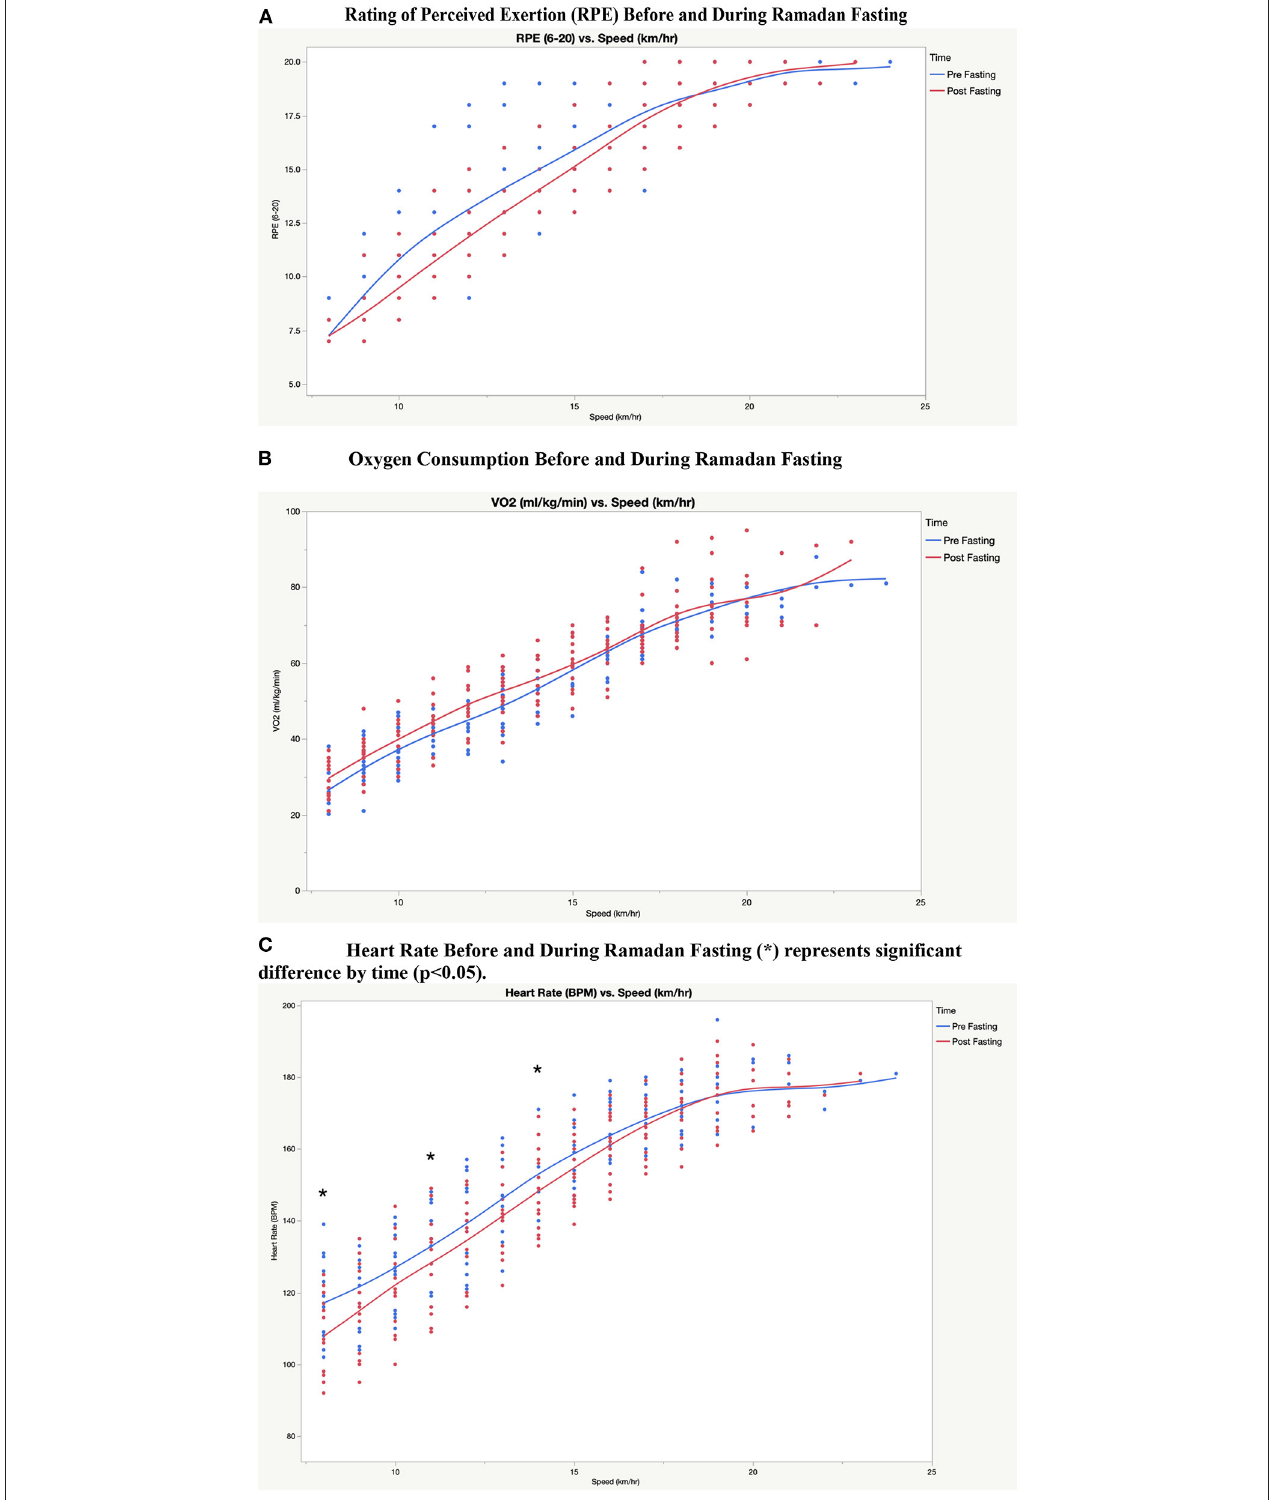
FIGURE 1 | (A) Rating of Perceived Exertion (RPE) before and during Ramadan fasting. (B) Oxygen Consumption Before and During Ramadan Fasting. (C) Heart Rate Before and During Ramadan Fasting (*) represents significant difference by time ( p < 0.05).